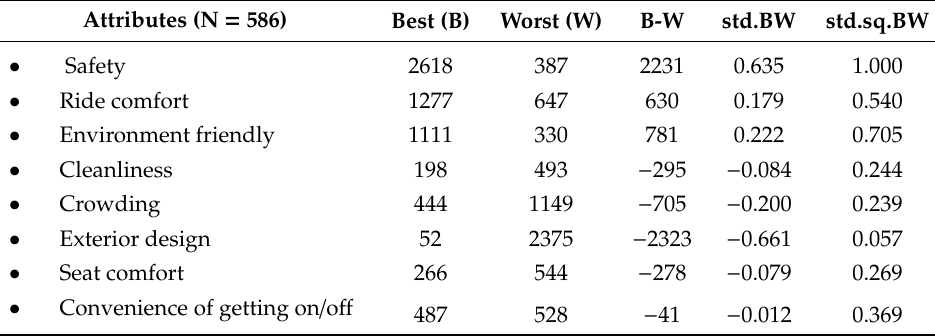
Table 5. Best-worst scaling scores (counting approach). Attributes (N = 586) Best (B) Worst (W)